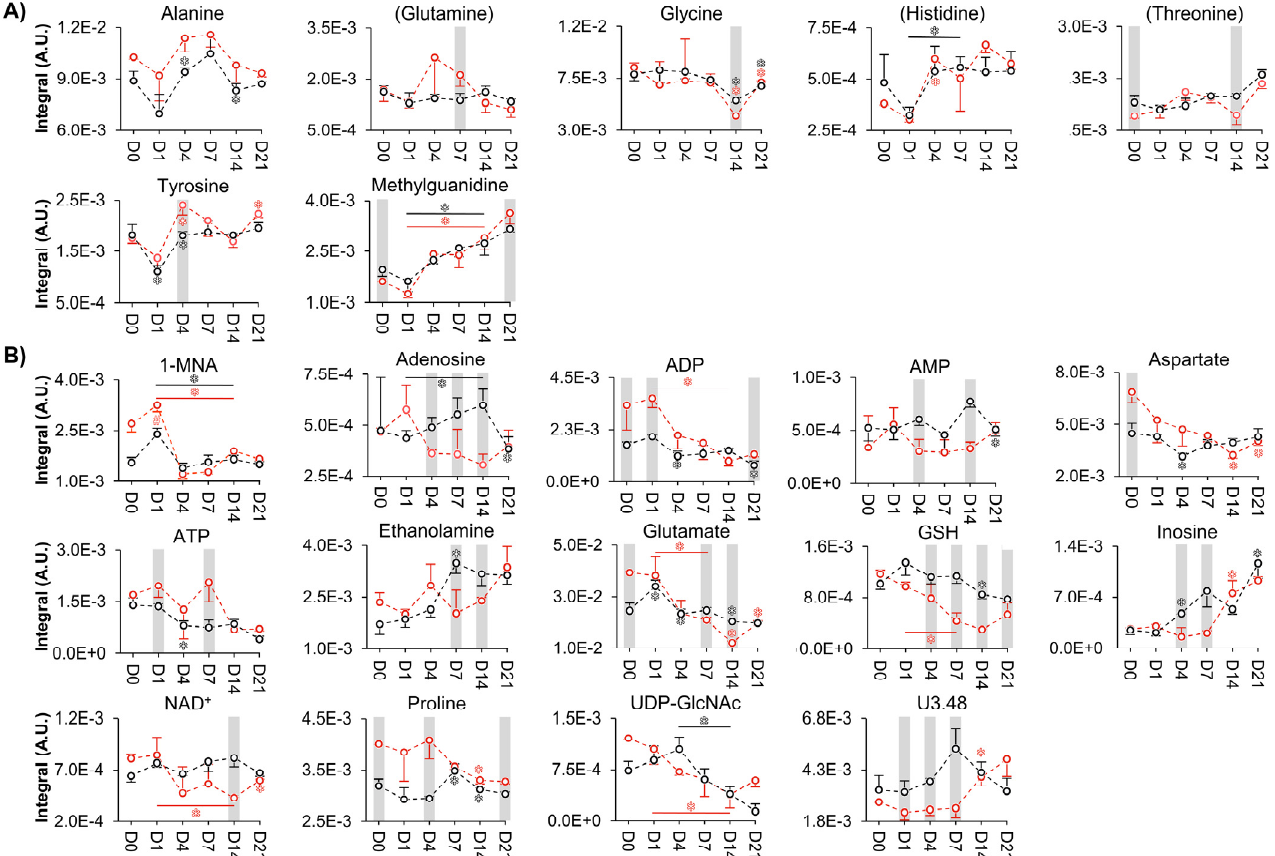
Figure 3. Donor-independent metabolic variations specific to hAMSCs proliferation. The line graphs display the normalized integrals of metabolites from donor 1 (dashed black lines) and 2 (dashed red lines) that ( A ) vary similarly throughout the 21 days or ( B ) converge at the end. Metabolite names in brackets identify compounds with peaks close to the noise level. 1-MNA, 1-methyl-nicotinamide; ADP, adenosine diphosphate; AMP, adenosine monophosphate; ATP, adenosine triphosphate; GSH, glutathione (reduced); NAD + , nicotinamide adenine dinucleotide; U δ , unassigned signal at δ chemical shift; UDP-GlcNAc, uridine diphospho- N -acetylglucosamine. Symbols (represented in the same colour as the corresponding line): *, Wilcoxon Rank-sum test p -value < 0.05 compared to the previous timepoint (shown only in cases where spectral confirmation was observed); #, relevant variations compared to the previous timepoint exclusively based on visual inspection (applicable when n < 3 samples, i.e., day 0 from donor 1). Grey bars highlight statistically significant differences ( p- value < 0.05) for each timepoint between donors (except for day 0, in which the grey bars refer to relevant variations exclusively based on visual inspection because n = 2 for donor 1).